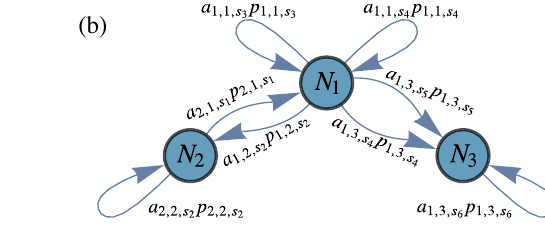
coefficients. The contractions of the operators j p ih q j lead to the terms p α ; β ;s